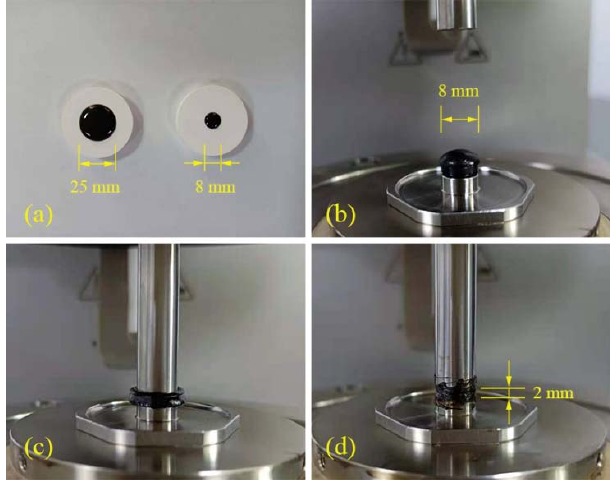
Figure 4. Schematic diagram of elastic recovery rate test process.